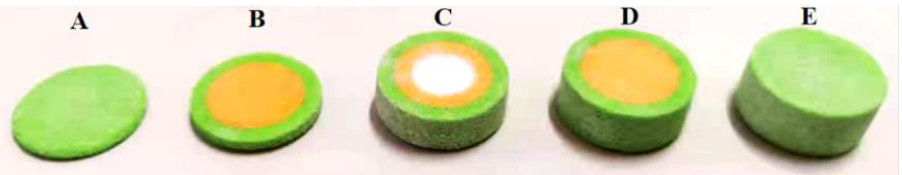
Figure 10. Structure diagram for the 3D-printed compound LEV-PN multi-compartmental struc- tured dispersible tablet. ( A ): 1 – 7 layers; ( B ): 1 – 13 layers; ( C ): 1 – 38 layers; ( D ): 1 – 44 layers; ( E ): 1 – 50 layers [72].